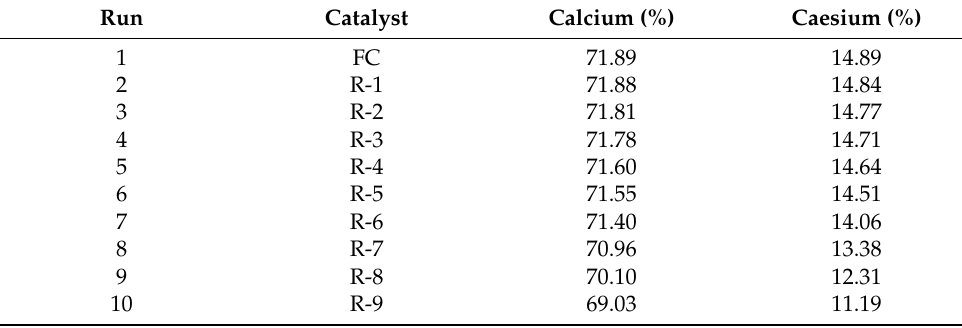
Table 6. EDS analysis of the fresh catalyst (FC) and its used form after each experimental run (R-1–R-9). Run